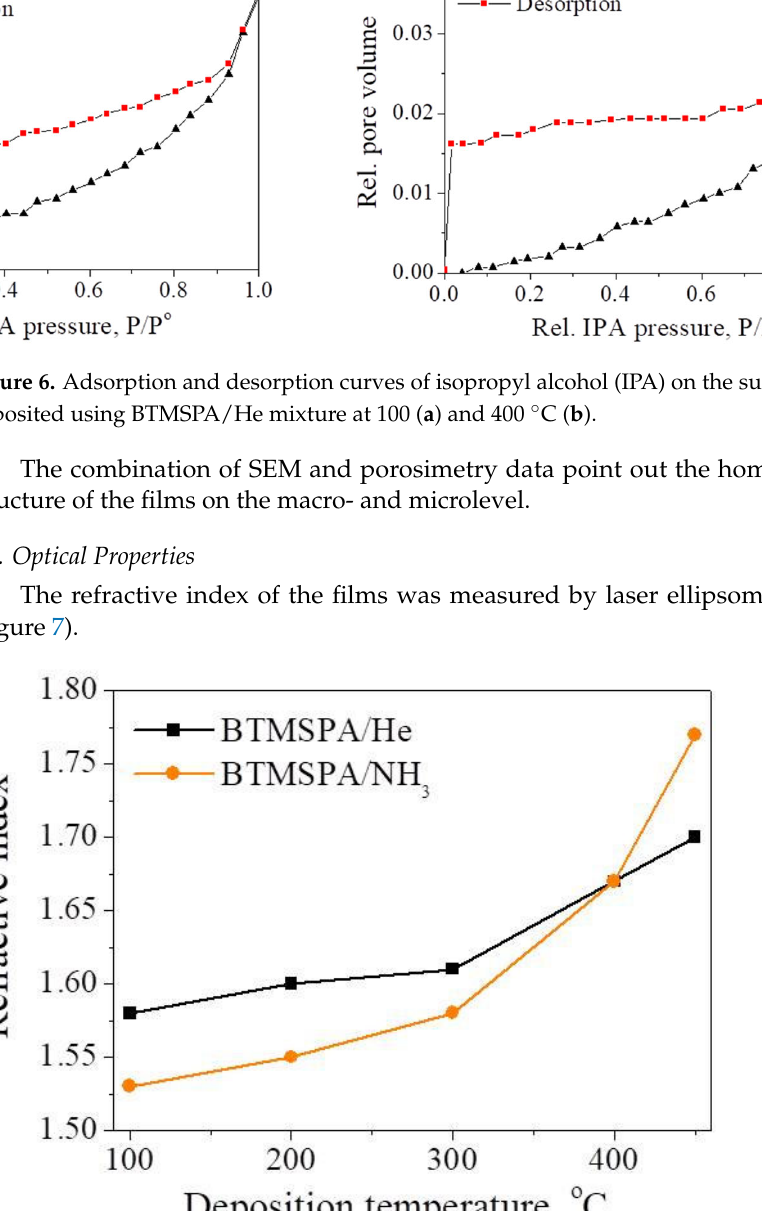
Figure 7. Evolution of refractive index of SiCN films deposited using different reactive mixtures.